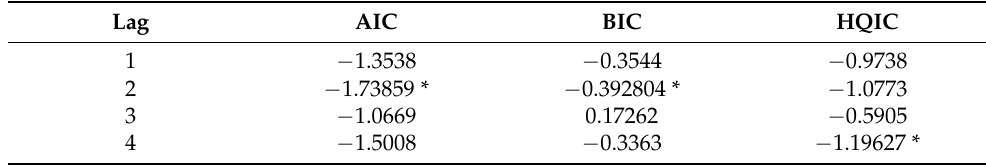
Table 4. The results of optimal lag order selection.